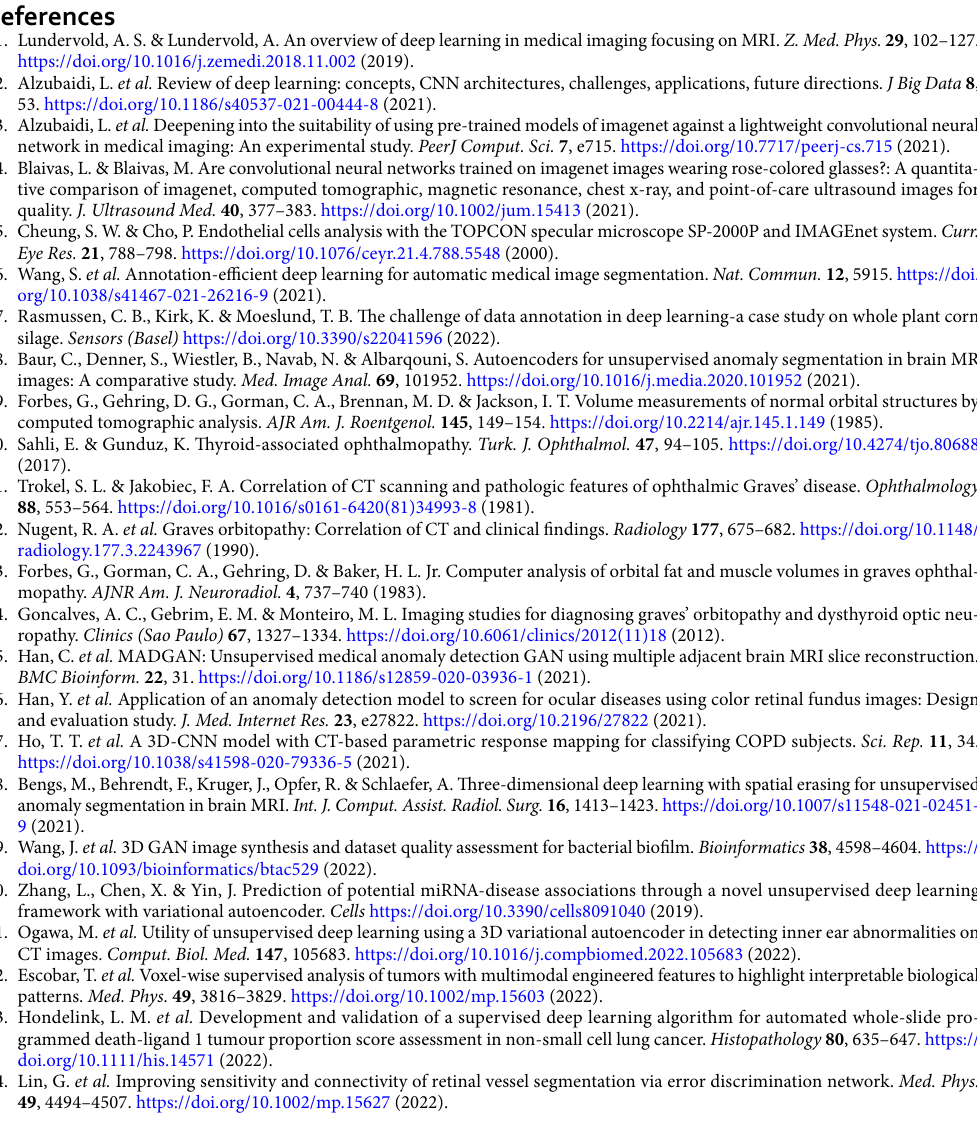
To evaluate model performance, images in the normal validation CT group were labeled with 0, whereas while those in the abnormal CT group were labeled with 1. We performed receiver operating characteristic (ROC) curve analysis using the output total loss values from normal and abnormal CT groups and identified the optimal cut-off 37 . The difference map: visualization of differences between input and output images. Pixel val- ues between each input and output images were squared pixel-wisely to emphasize differences between input and output images. The pixel position where there was a large difference was expressed in red, and the pixel position where there was a small difference was expressed in blue, like conventional heat map